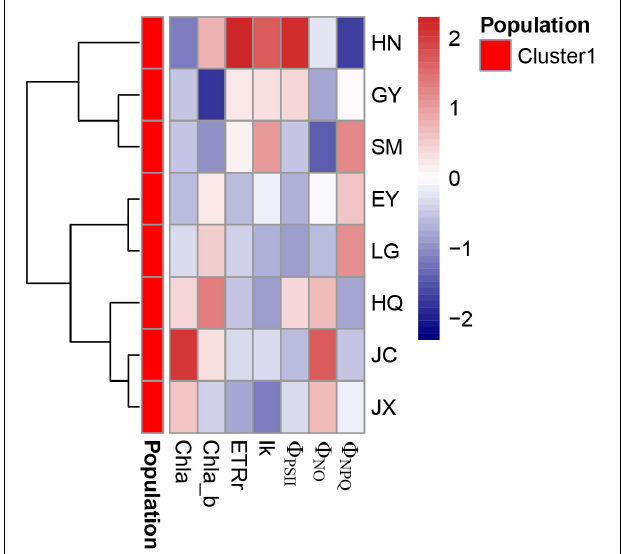
FIGURE 5 | The cluster analysis of pigment-related leaf traits in the eight populations. Chla, Chlb, Car, and Chla/b refer to the leaf chlorophyll a